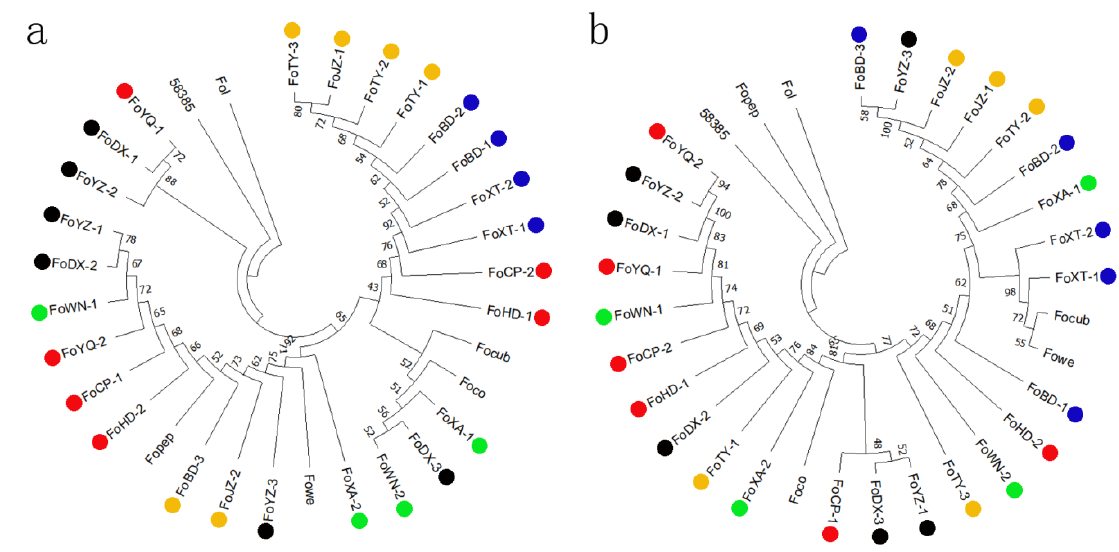
Figure 3. Phylogenetic tree constructed by of EF-1a ( a ) and ITS ( b ) gene sequences using the neighbor-joining (NJ) tree method. Red, blue, yellow, black, and green circle represent the FOC1 isolates collected from Beijing, Hebei, Shanxi, Gansu and Shaanxi Provinces, respectively.